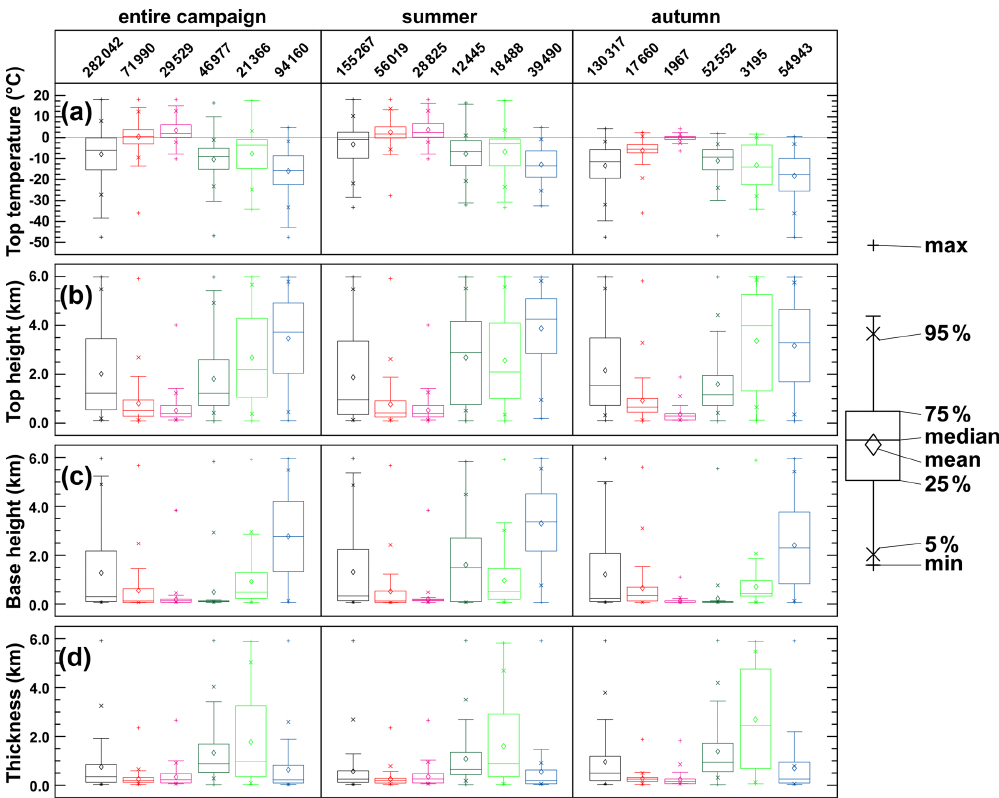
Figure 6. Statistical overview of cloud occurrence with respect to (a) top temperature, (b) top height, (c) base height, and (d) geometrical thickness for the entire ACSE campaign (left column) as well as for summer (middle column) and autumn (right column). The colours indicate the different cloud types as in Fig. 5: all (black), non-precipitating liquid (red), precipitating liquid (magenta), non-precipitating mixed phase (dark green), precipitating mixed phase (light green), and ice (blue). The numbers in the top panel refer to the number of 30s profiles considered in the